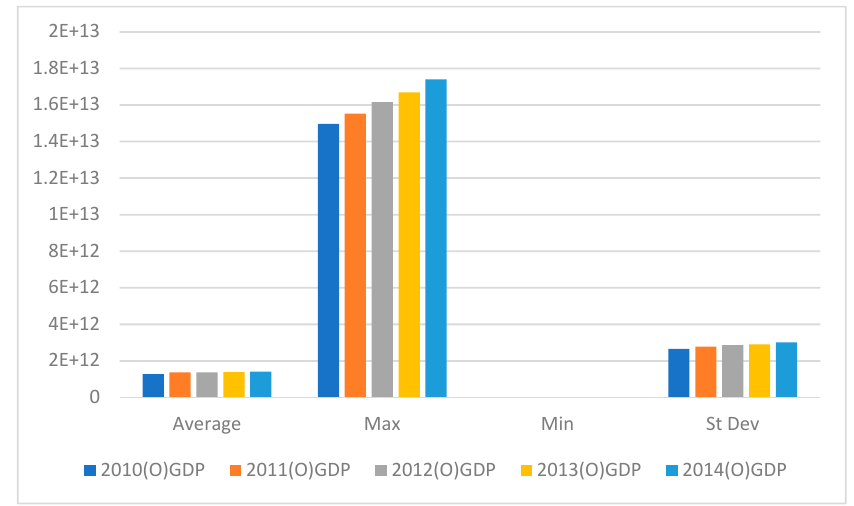
Figure 5. GDP output variables from 2010-2014.